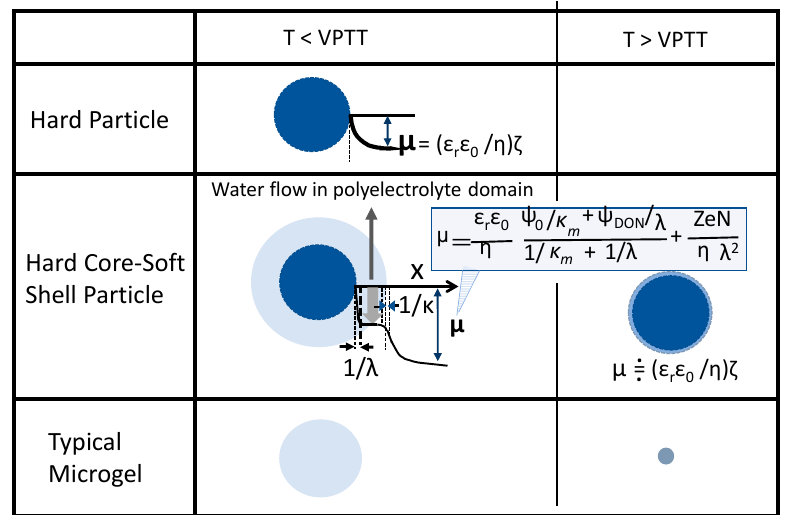
Figure 8. Colloid and surface chemistry of microparticles (Equation (2)).